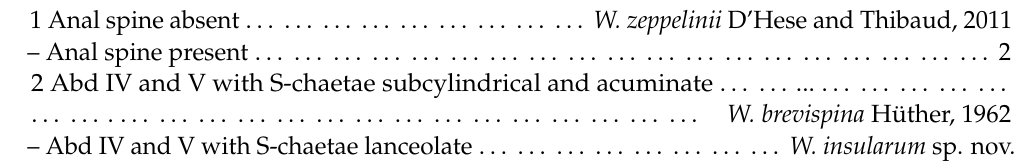
Figure 24. Distribution map for Willemia Börner, 1901 species recorded in Brazil. Scale bar: 3000 km. Identification Key for Willemia Species Recorded in Brazil